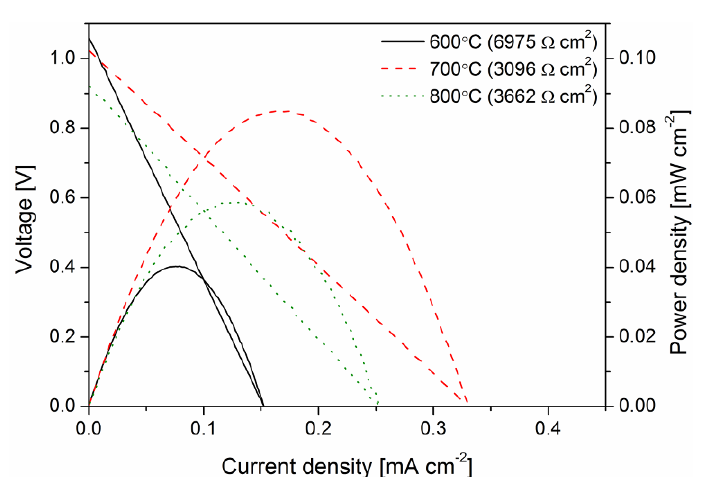
Figure 10. Voltage and power density as a function of current density of solid oxide fuel cell supported on SrZr Numbers in brackets denote total cell polarization.